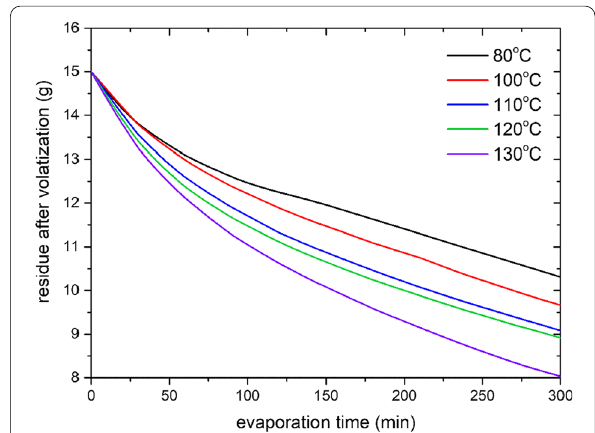
Fig. 2 Volatilization rate of naphtha and PGMEA according to the hot plate